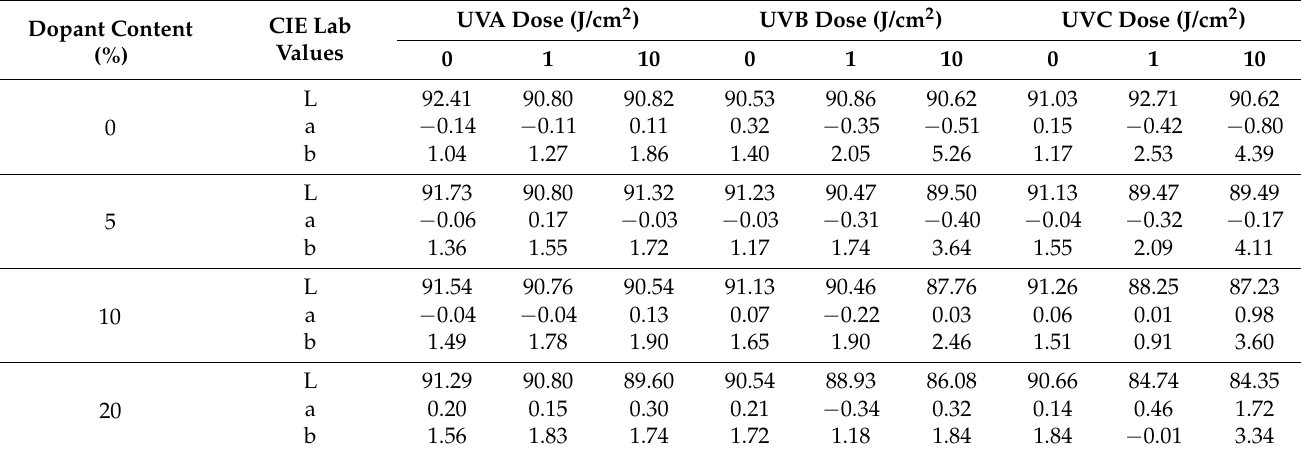
Table 1. CIE Lab parameters of paper doped with PAN–PDA fibres derived from reflectance measurements of samples irradiated with UV light (non-refined paper).